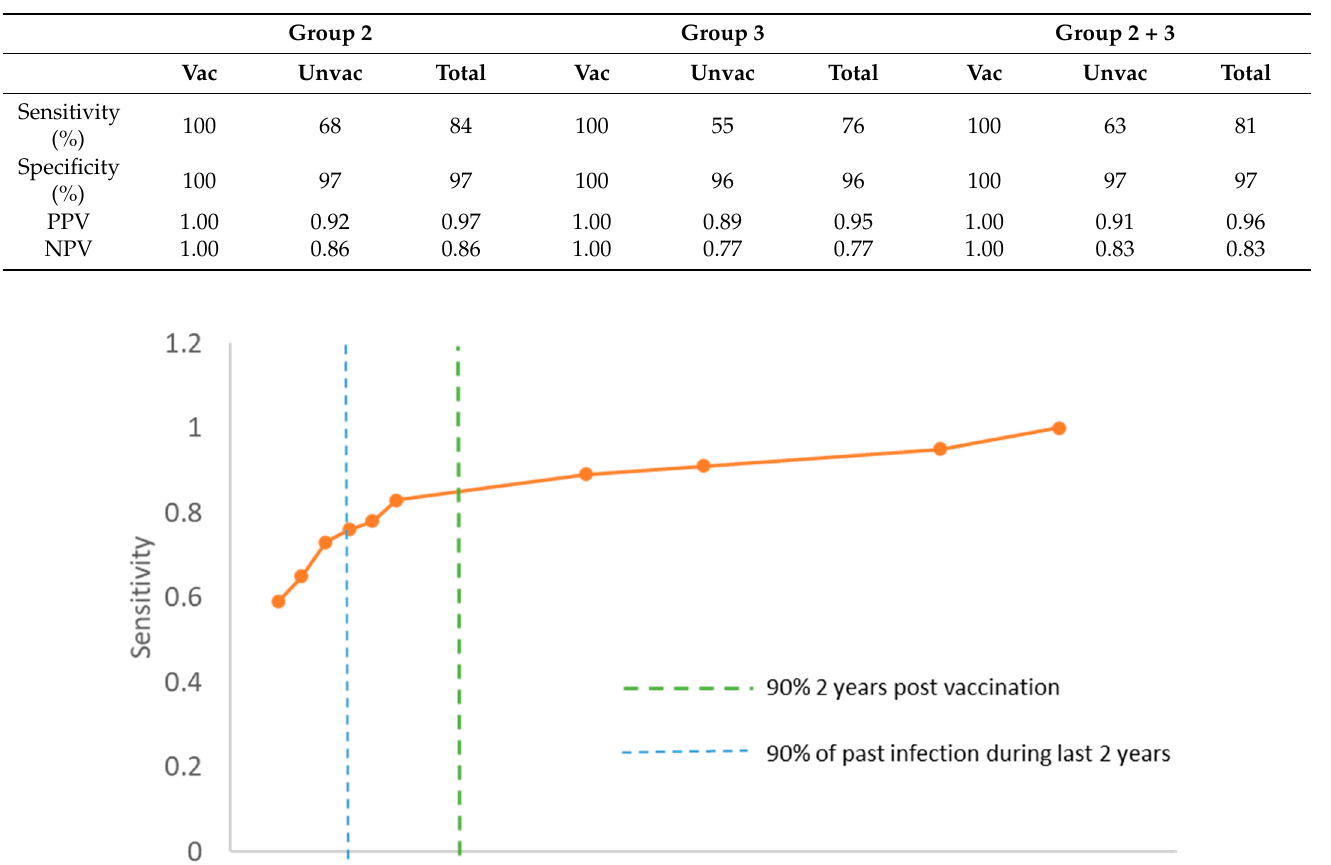
Table 3. Clinical performance of DBS vs. plasma in detecting positive HEV IgG samples in HEV 239 vaccinated (Vac) and unvaccinated (Unvac) participants.